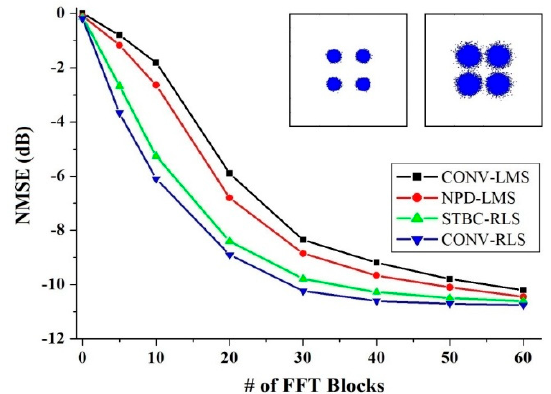
Figure 13. The normalized mean square error (NMSE) vs. the number of fast Fourier transform (FFT) blocks for various algorithms for a polarization-division multiplexing (PDM) quadrature phase shift keying (QPSK) signal; inset: constellation diagrams before ( right ) and after ( left ) the STBC-RLS compensation [27].